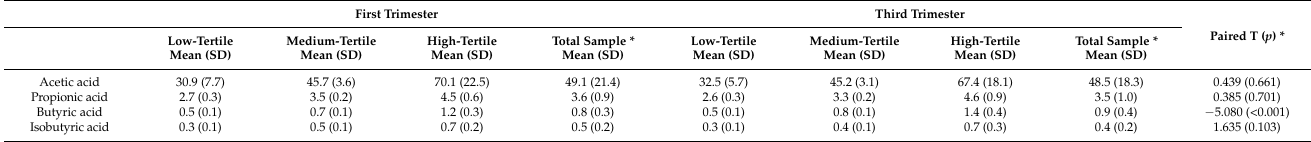
Table 3. Mean SCFA scores per tertile and trimester of